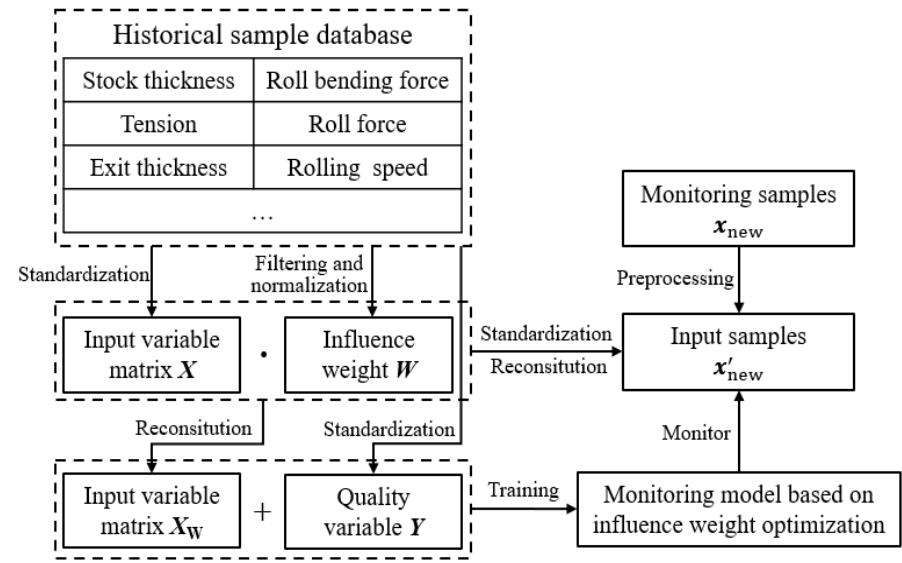
Figure 7. Monitoring model based on influence weight optimization.